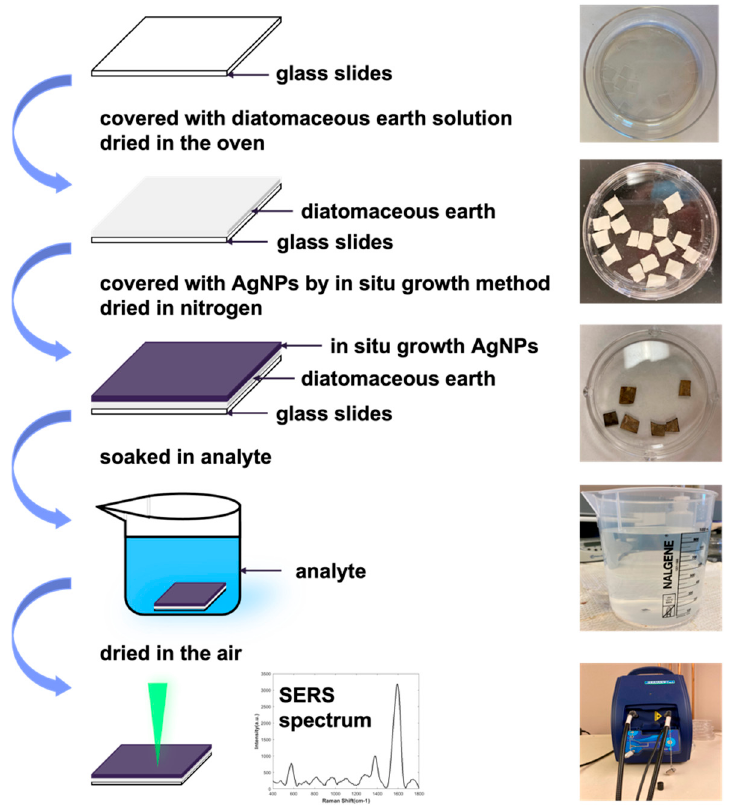
Figure 1. Fabrication process of the SERS substrate using in situ growth of AgNPs on diatomaceous earth. The lowest figure illustrates the characteristic SERS spectra of fentanyl obtained by a portable Raman spectrometer.